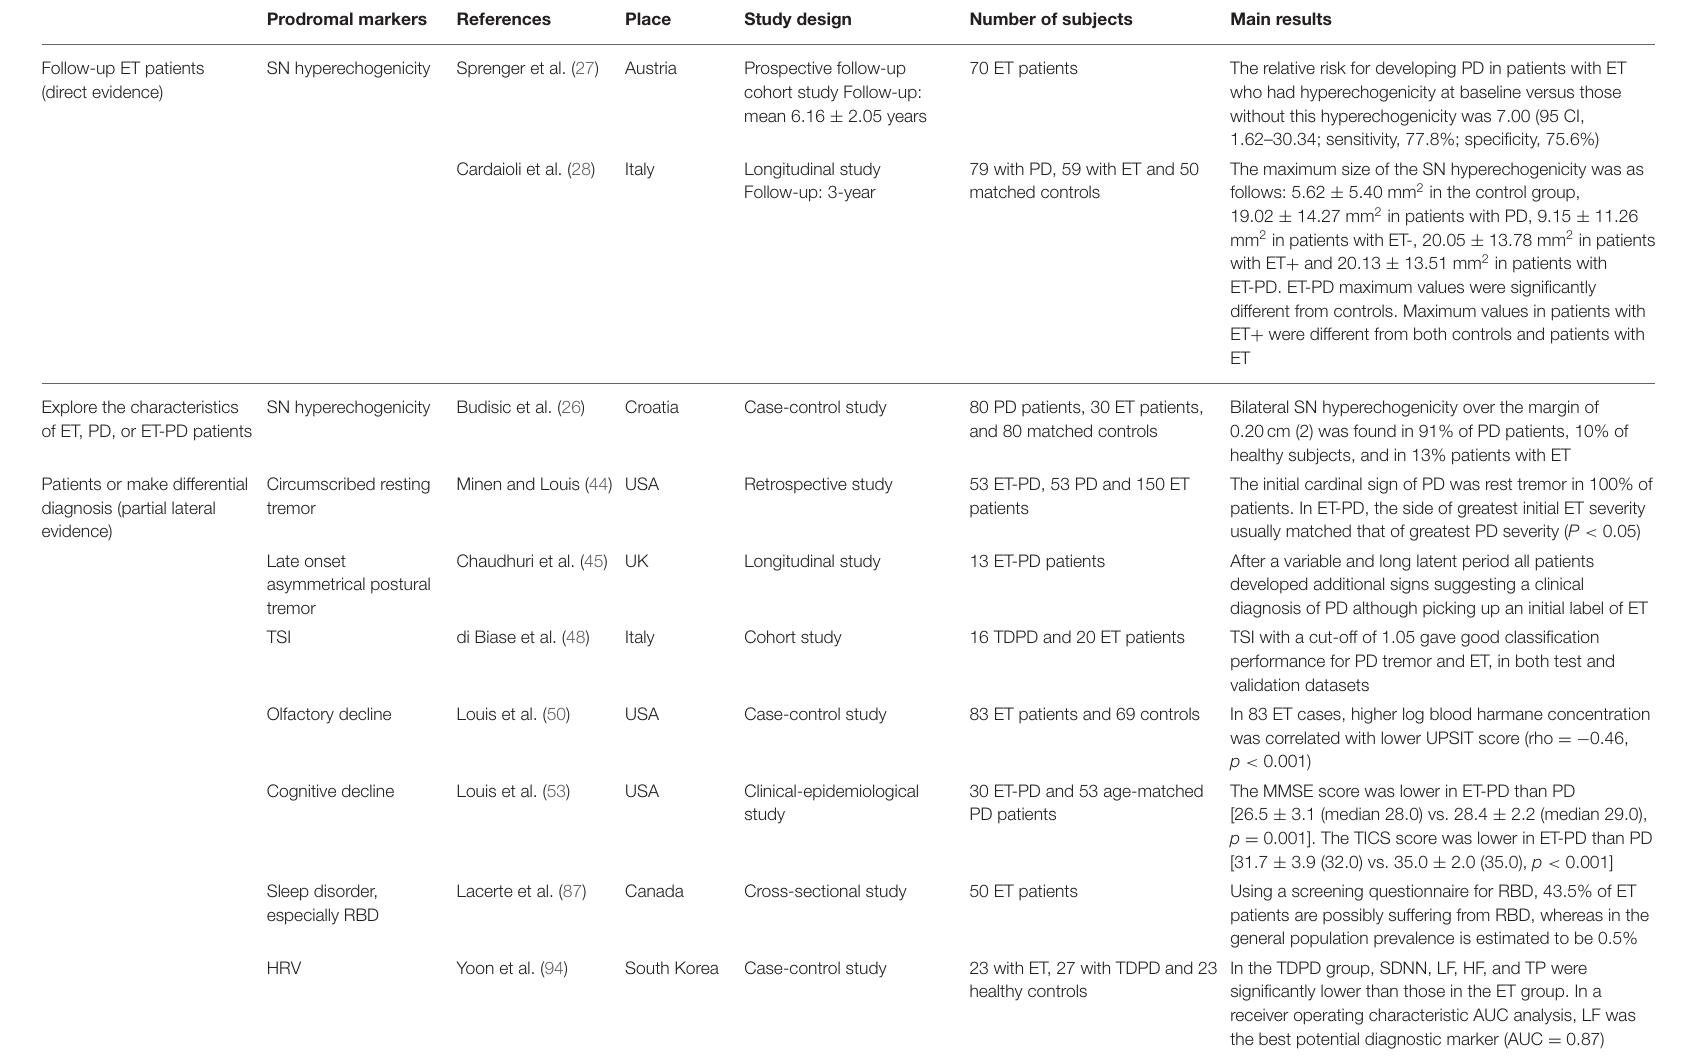
TABLE 4 | Brief summary of study design with regard to different prodromal